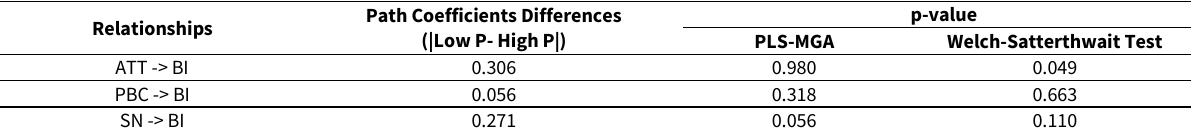
Table 2. PLS-MGA